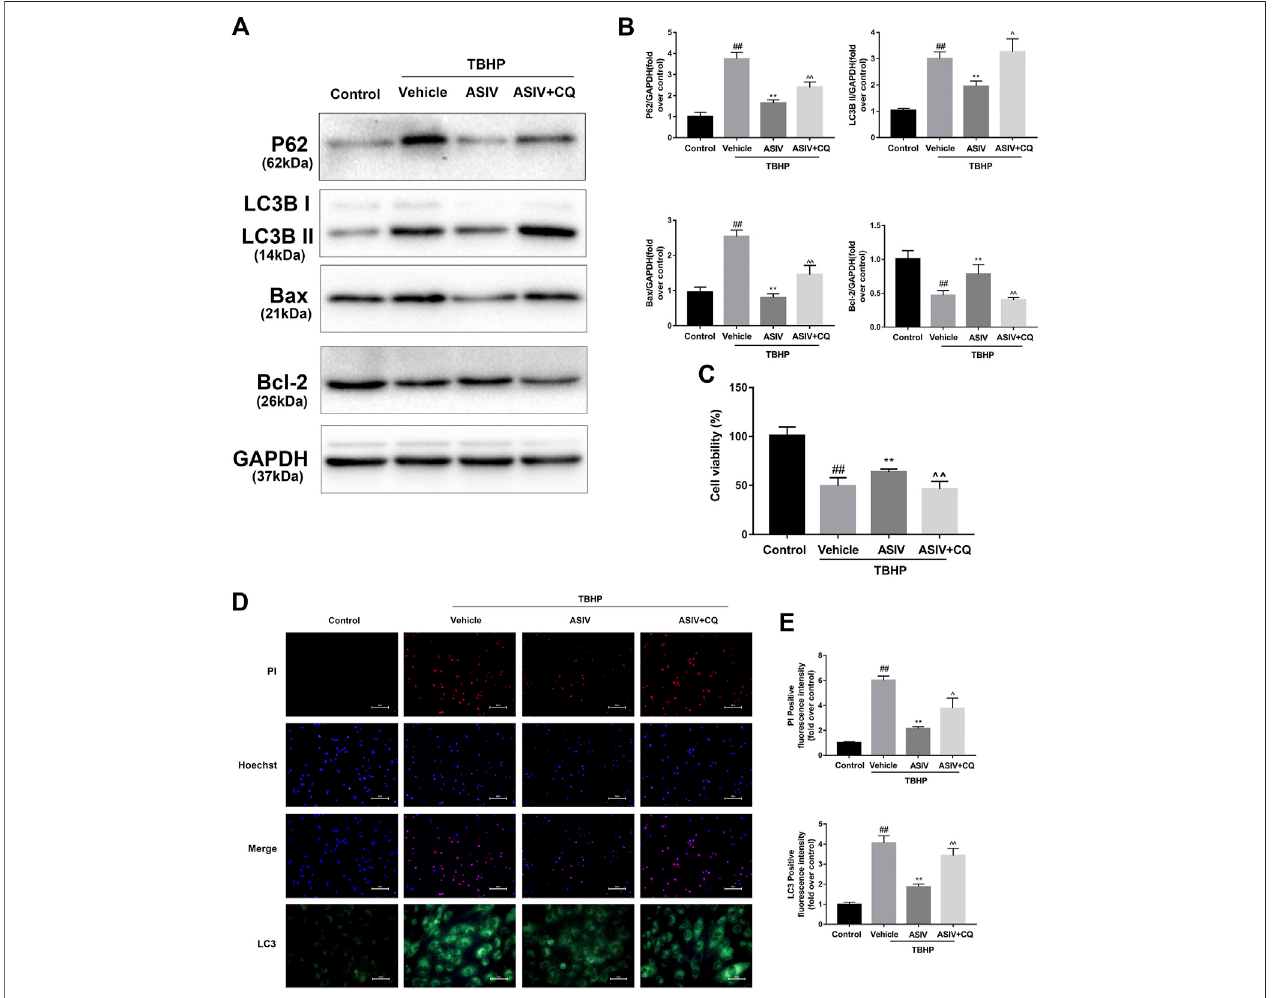
FIGURE 5 | ASIV attenuated TBHP-induced injury via attenuating I/R-induced autophagosome accumulation in vitro. After H9C2 cells were pretreated with ASIV and CQ for detection of (A, B) Western blot indicating expression of LC3B, P62, Bax and Bcl-2 proteins. (C) cell viability, (D, E) Representative immuno fl uorescence images of H9C2 loaded with LC3 and PI/Hoechst stain. Scale bar: 25 μ m for LC3 immuno fl uorescence and 50 μ m for PI/Hoechst stain. n (cid:2) 6. Values are expressed as themeans ± SD.# p < 0.05compared withthecontrolgroup, * p < 0.05compared withtheTBHP group, ^ p < 0.05compared withASIV pretreated group(eachtest was repeated three